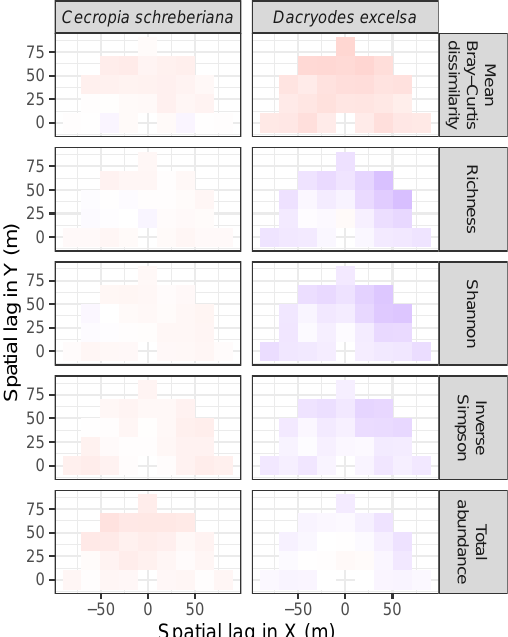
Figure 15. Codispersion between measures of diversity and total basal area of the two focal tree species in 20 20-m subplots in the 16-ha Luquillo plot. Codispersion coefficients were calculated for spatial lags ranging from 0–80 m at 20-m intervals. The value of the codispersion coefficient can range from − 1 (dark blue) through 0 (white) to 1 (dark red). Statistical significance of each codispersion coefficient is shown in Figures 18 and A3.